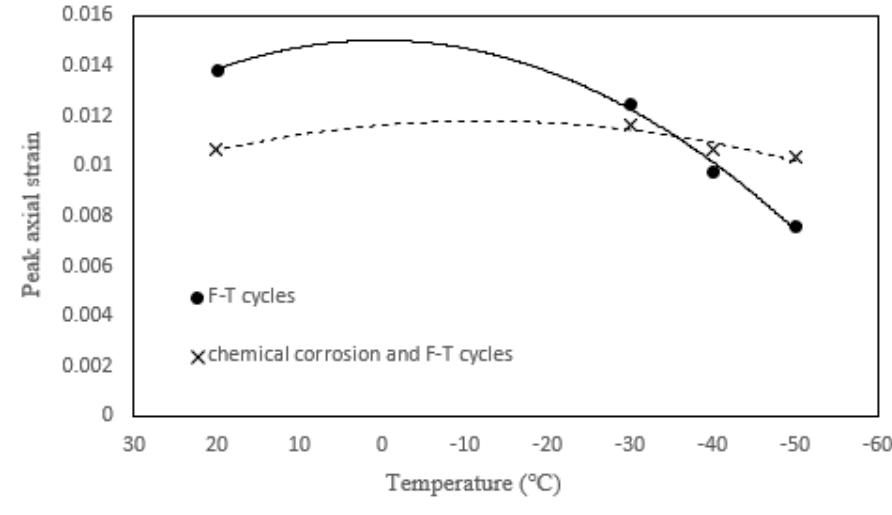
Figure 6. The peak axial strain ε f of tonalite specimens.